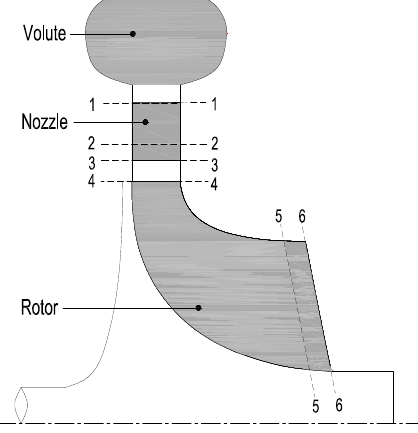
Figure 1. Components of a radial inflow turbine.